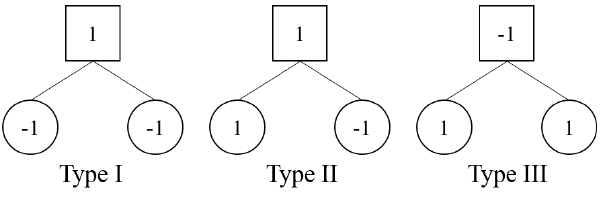
Figure 3. Different types of